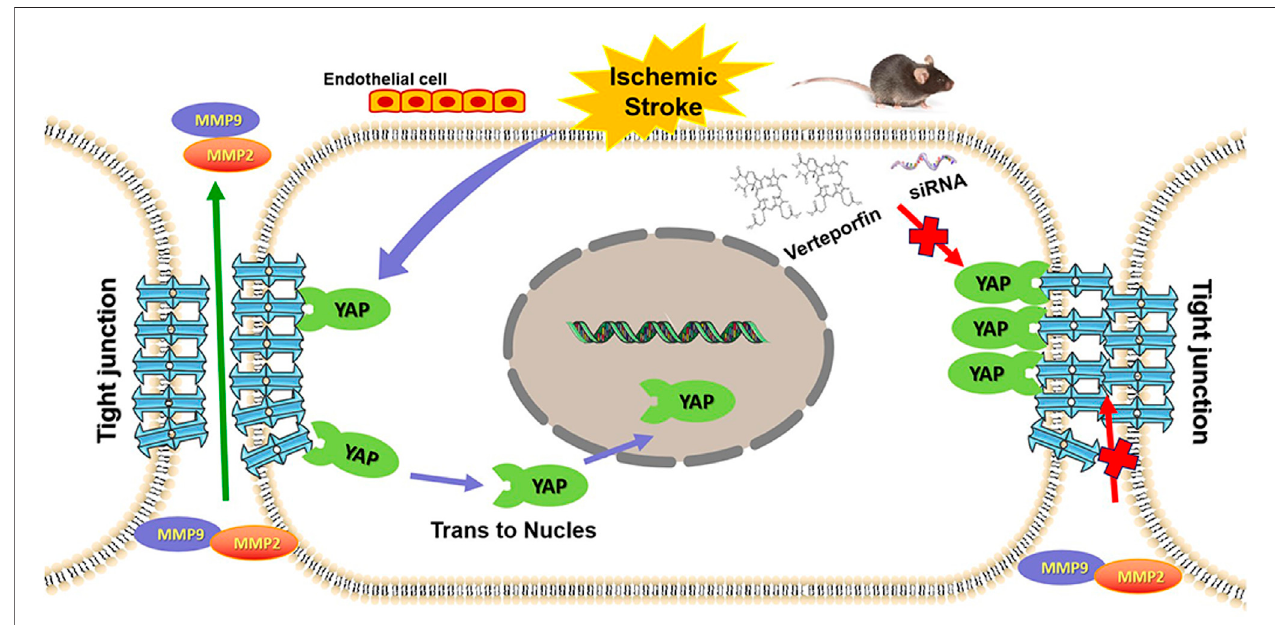
FIGURE 9 | Graphic abstract depicting the role played by YAP to protect against BBB disruption in cerebral ischemia-reperfusion injury.